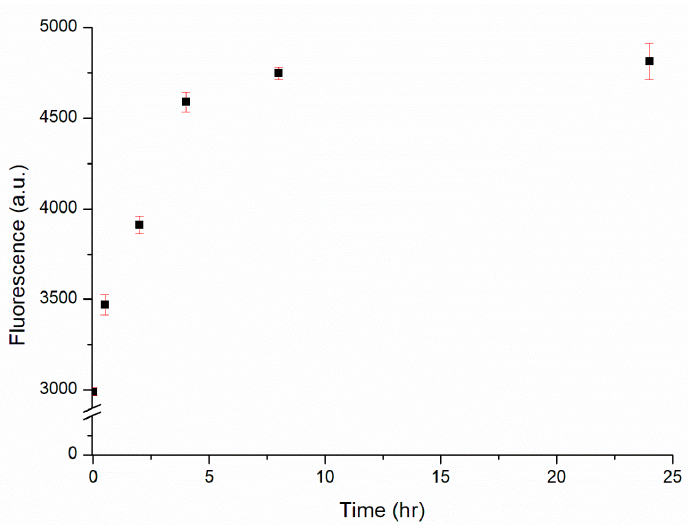
Figure 4. Fluorescence intensity of the DNAzyme complex (30 nM) in the presence of 1 μ M Cu 2+ over reaction times from 0.5 to 24 h. The proposed biosensor used PPi-captured Cu 2+ as a trigger for the hydrolysis of the top performance. Two units of PPi, which chelates the Cu 2+ ion, is the substrate of PPase. The DNAzyme complex was added after the mixing of 1 μ M of Cu 2+ with various PPi con- centrations. Then, the solution was incubated for 4 h before measuring. Figure 5 displays the fluorescence intensity of the biosensor measured at various concentrations of PPi. Strong fluorescence appeared at low PPi concentrations. This intensity decreased signifi- cantly upon increasing the concentration of PPi, reflecting the greater chelation of Cu 2+ , which left a lower concentration of free Cu 2+ ions to trigger the hydrolysis of the substrate by the DNAzyme in the absence of PPase. When 10 μ M of PPi had been added, the fluo- rescence intensity became steady; even when the concentration of PPi reached 30 μ M, there was no significant decrease in fluorescence, suggesting that the chelation of Cu 2+ by PPi had reached a stable situation. Because a large concentration of PPi would lower the sensitivity of the biosensor, the optimized concentration of PPi used to capture the Cu 2+ ions in subsequent experiments was 10 μ M, thereby ensuring that no free Cu 2+ ions would be available to trigger the DNAzyme-mediated hydrolysis prior to the catalysis initiated by PPase.